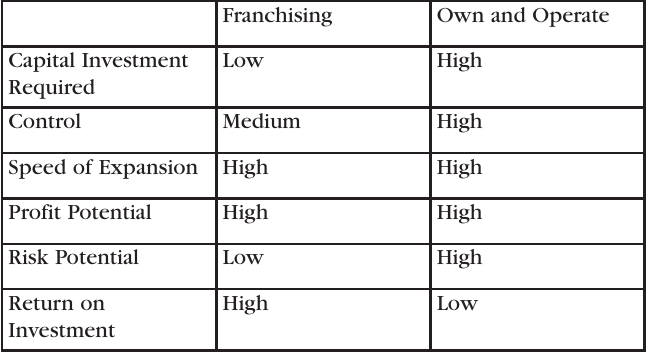
Table 6. Comparison of Risk/Reward for Franchising and Owner-Operated